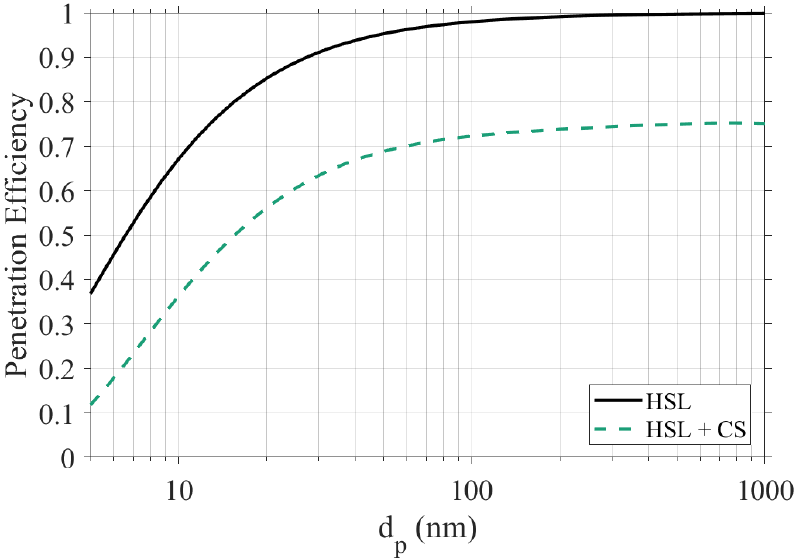
Figure 2. Correction model for penetration efficiencies of particles to the DMS after transfer through the heated sampling line (HSL) and after combined HSL plus catalytic stripper (CS). Model provided by Cambustion.